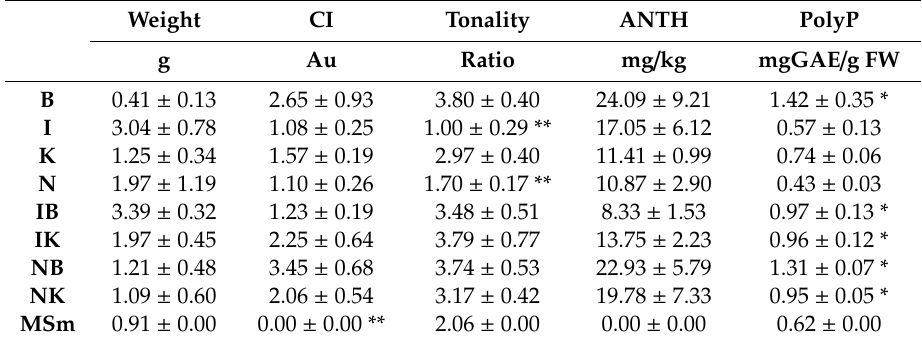
Table 1. Mean and ( ± ) standard error of the mean for all the treatments for all the callus masses, and physicochemical parameters (color intensity, tonality ratio, anthocyanin content and polyphenolic content). Weight CI Tonality